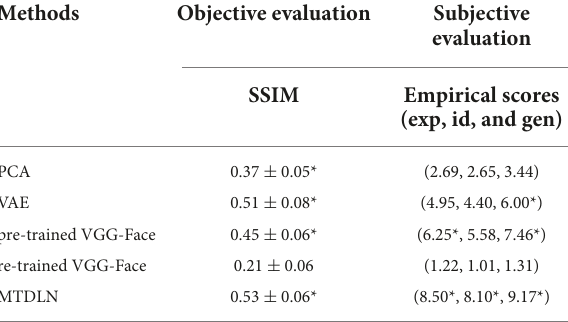
TABLE 4 Quantitative evaluation of reconstruction performance by using five different face-feature extraction models.